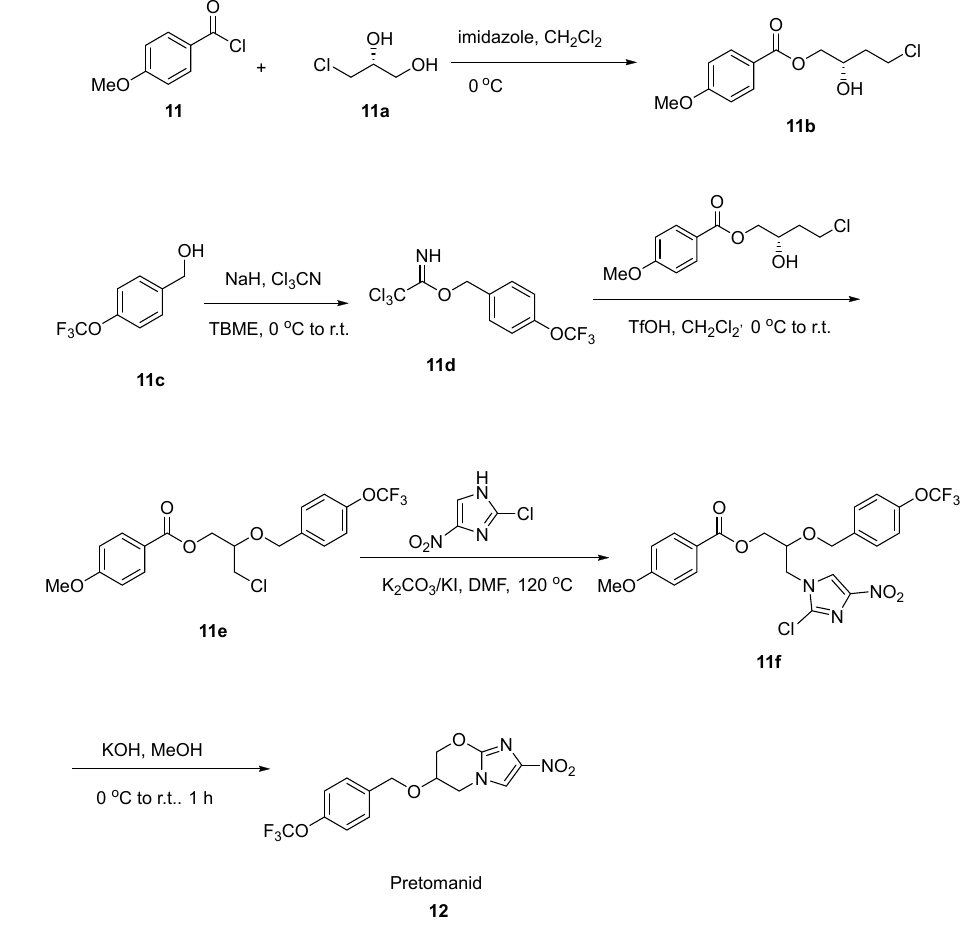
Figure 6. Synthesis and structure of